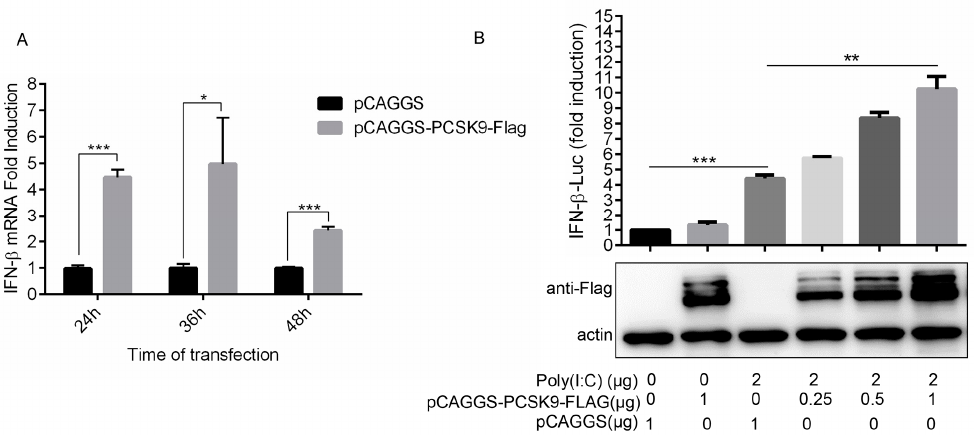
Figure 4. PCSK9 promotes interferon production in a dose-dependent manner. ( A ) MARC-145 cells were transfected with either pCAGGS-PCSK9-flag or the empty vector pCAGGS. At different time points as indicated after transfection, the cells were harvested and total RNAs were purified. The expression of IFN- β was assessed by RT-qPCR with specific primers for IFN- β . Error bar: mean ± SEM; *, p ≤ 0.05; ***, p ≤ 0.001. ( B ) HEK-293T cells were transfected with different amounts of